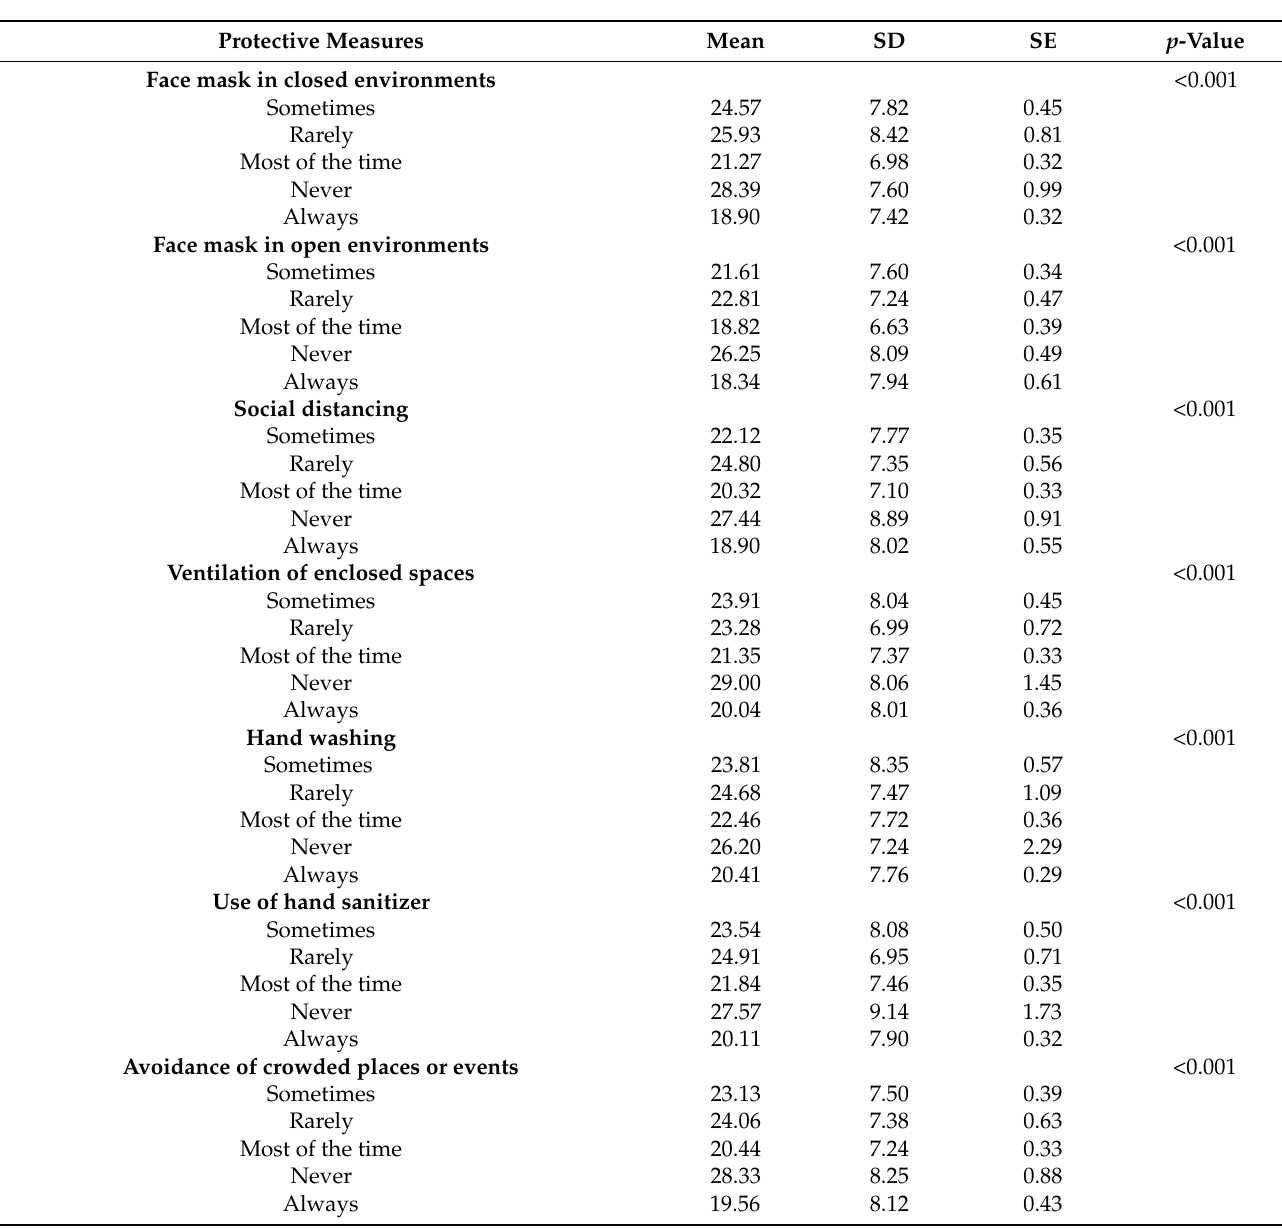
Table 3. Non-pharmacological protective measures against COVID-19 and association with the Pandemic Fatigue Scale (PFS scores) (N =